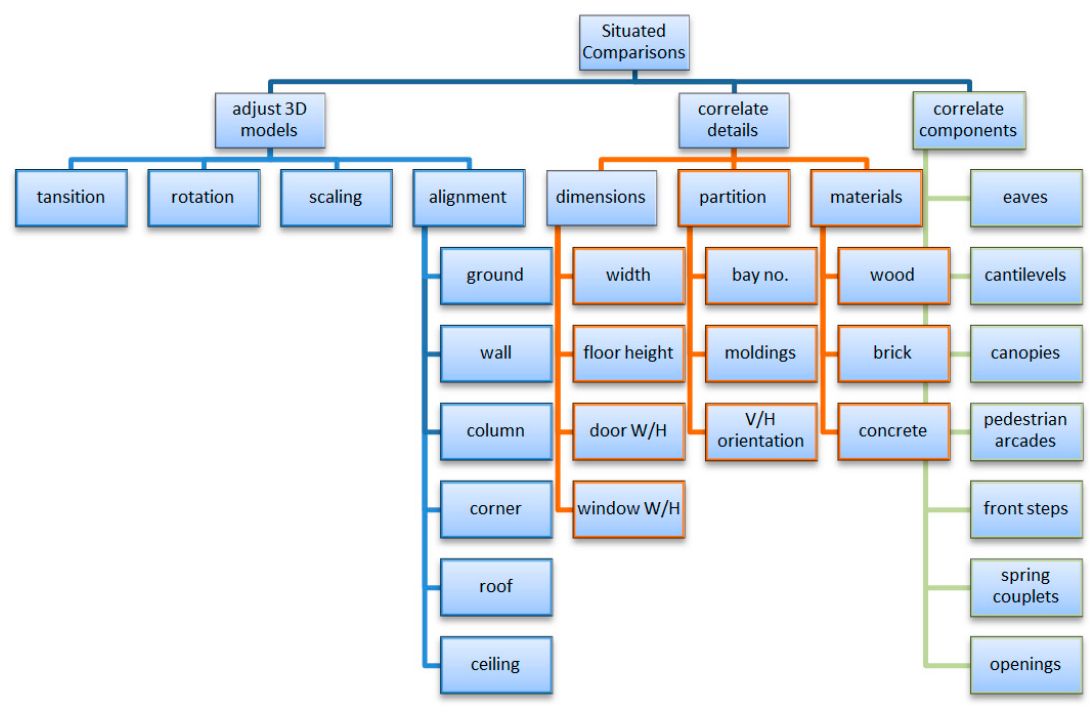
Figure 10. The situated comparison process.